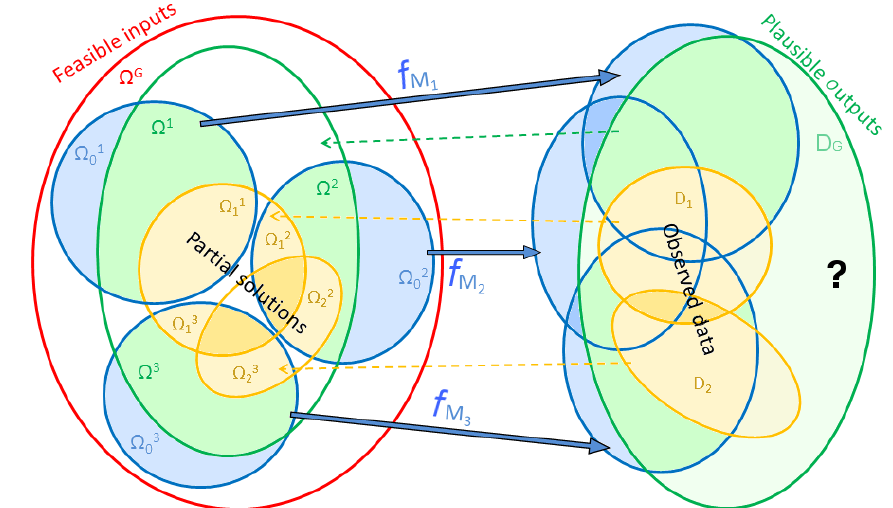
Figure 1. Diagram of input spaces, model functions, and output space (blue), with feasible inputs domain (red), plausible output codomain and specialized inputs (green), and observed data and partial solutions subsets (orange). The question mark emphasizes that the covering of other plausible outputs could be enabled by adding more models if